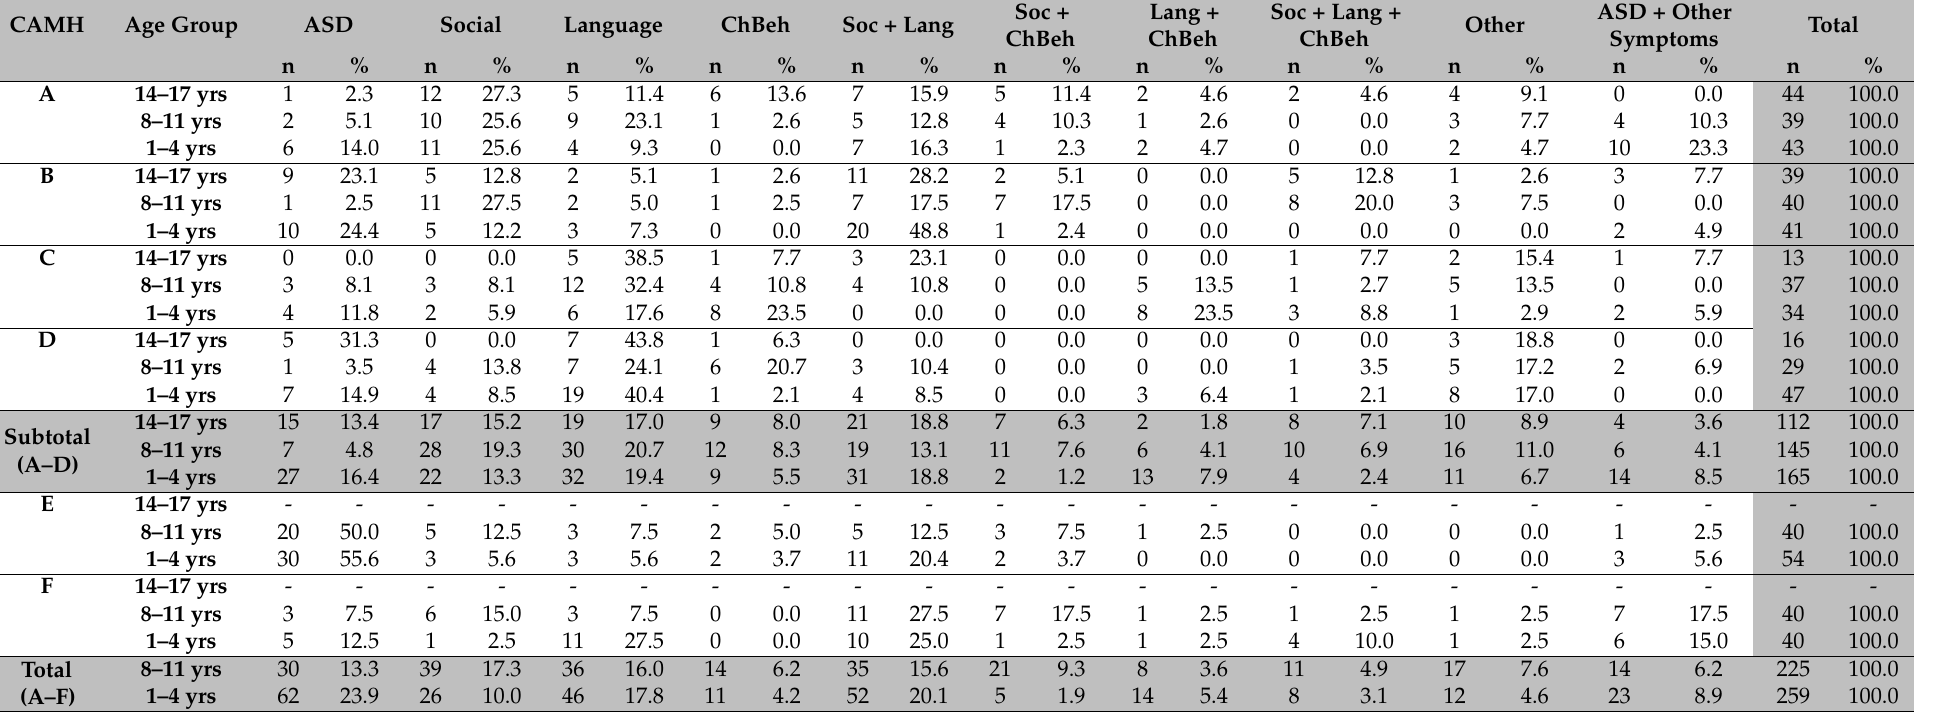
Table 4. Frequency of subjects by neurodevelopmental concerns for referral, CAMH unit and age